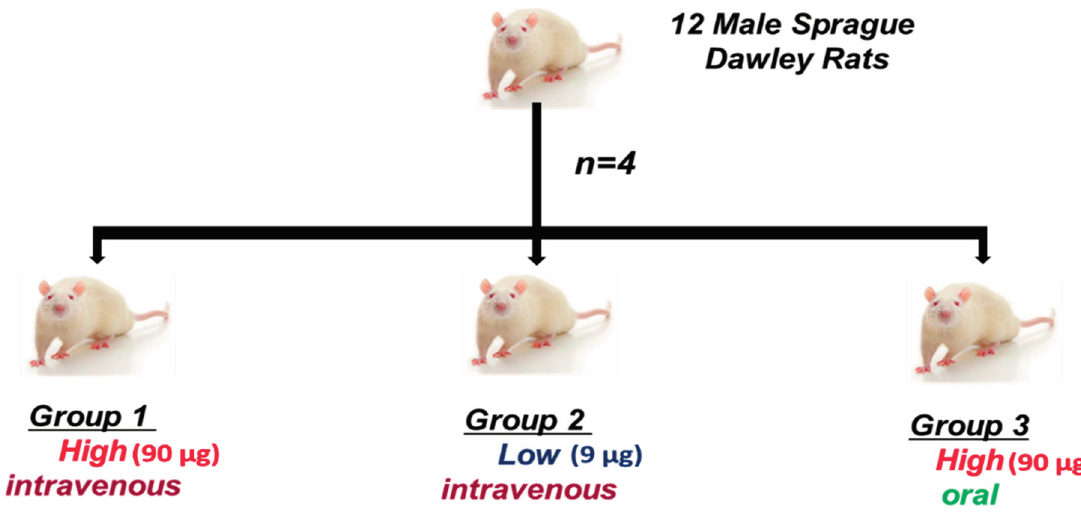
Figure 6. Study design of the animal experiment. Groups 1 and 2 received intravenous doses, while Group 3 got an oral